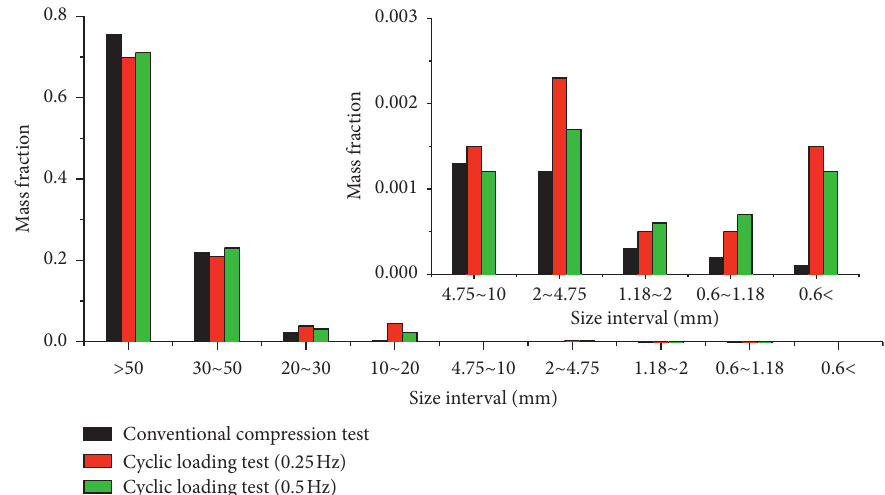
Figure 13: Mass fraction of limestone specimen fragments in different size intervals obtained under different test